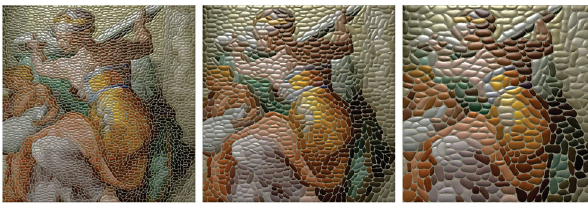
Fig. 13 Varying pebble size. Left to right: 3000, 1000, 500 pebbles.